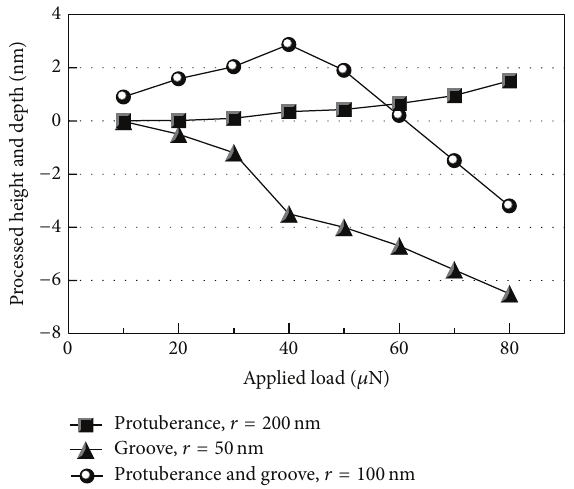
Figure 3: Tip radius and load effects on protuberance height and groove